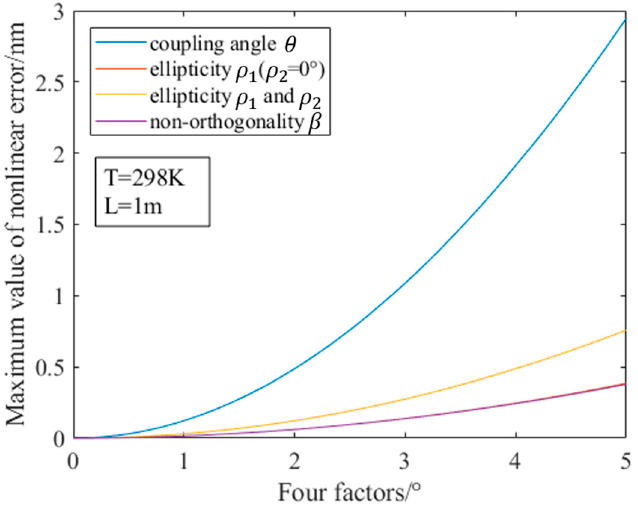
Figure 9. Comparison chart of the in fl uence of the four in fl uence factors on nonlinear error.